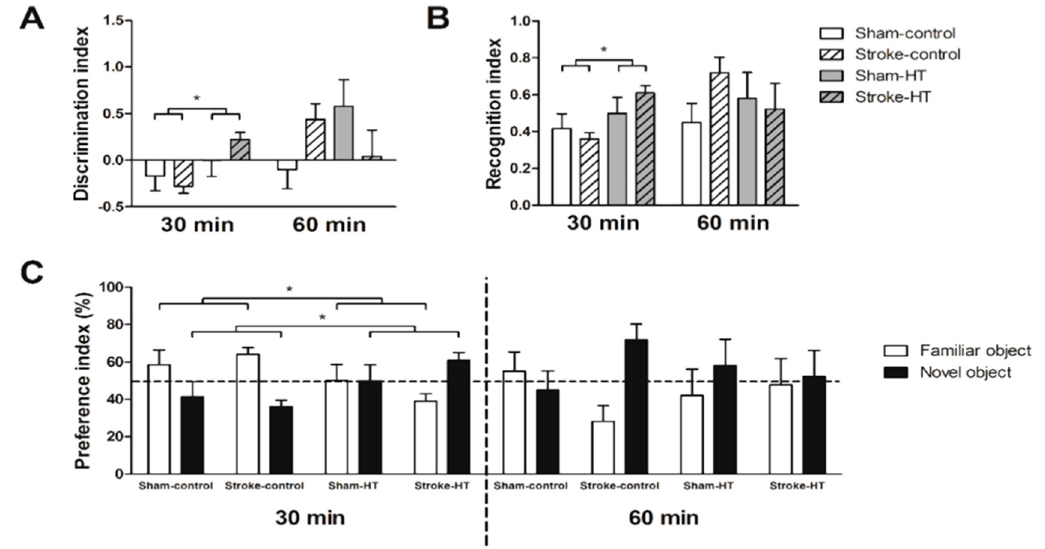
Figure 9. Test phase ORT. Short-term memory of sham and stroke mice assessed by the novel ORT. ( A ) Discrimination index, ( B ) Recognition index, and ( C ) preference index. ( A – C ) HT-fed animals